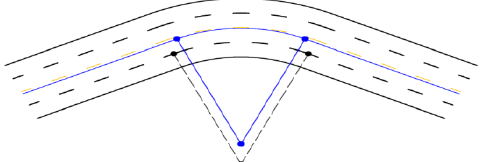
Fig.8 Concave curve of the driver’s desired trajectory (e) （ 6 ） Drivers desire to drive along the lane inside the center line. Starting point is left behind, and the ending point is advanced. And the curvature is reduced.